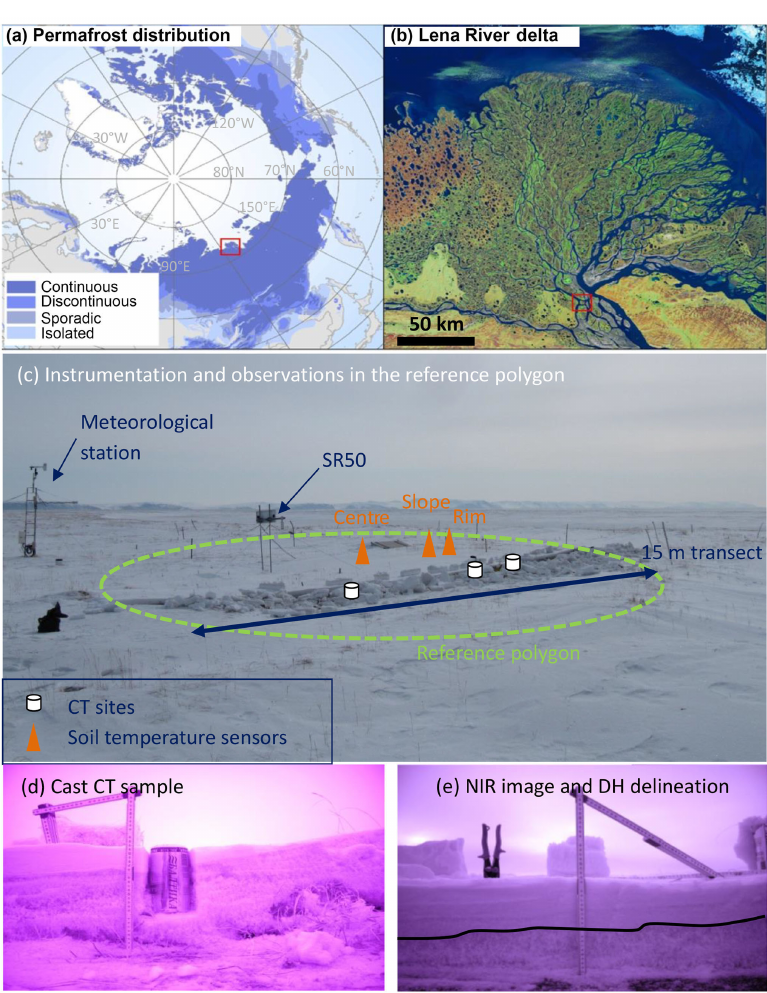
Figure 1. Location of the Samoylov permafrost observatory within the continuous permafrost zone, Lena River delta (a, b) ; instrumentation and observations in the reference polygon (c) ; cast CT sample (d) ; NIR image of a transect’s wall with the upper boundary of the DH layer delineated (e) . See main text for